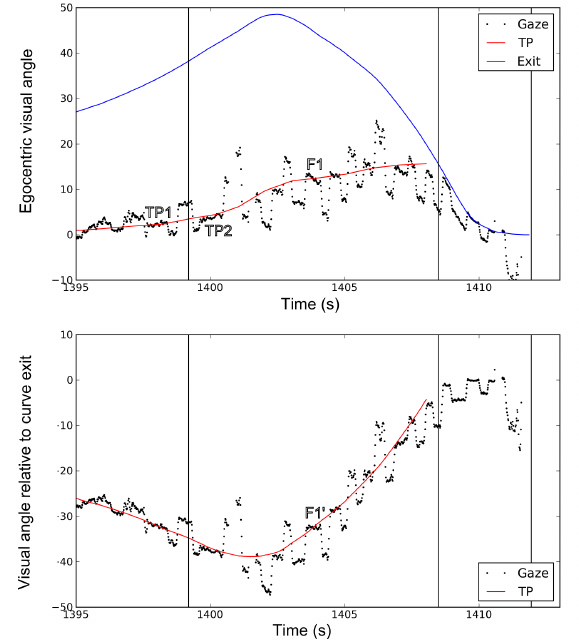
Figure 2. Top. Individual trial data from one participant, showing a typical pattern of pursuit-like/optokinetic movements during curve entry (curve 6, eastward). Red = tangent point, Blue = curve exit. The vertical lines mark the entry, yaw-max and exit points of the curve, as explained in the methods. Vertical axis is the visual direction of gaze (black) in reference to vehicle centerline (in degrees, positive = to the right).